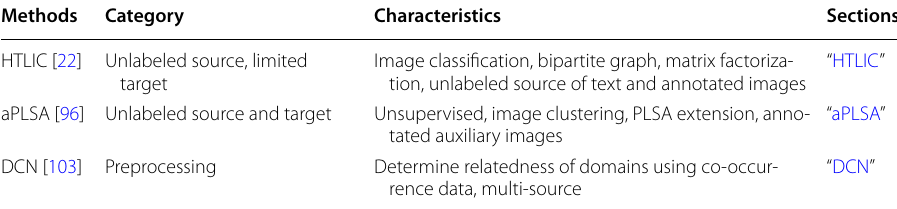
Table 4 Other surveyed HTL methods Methods